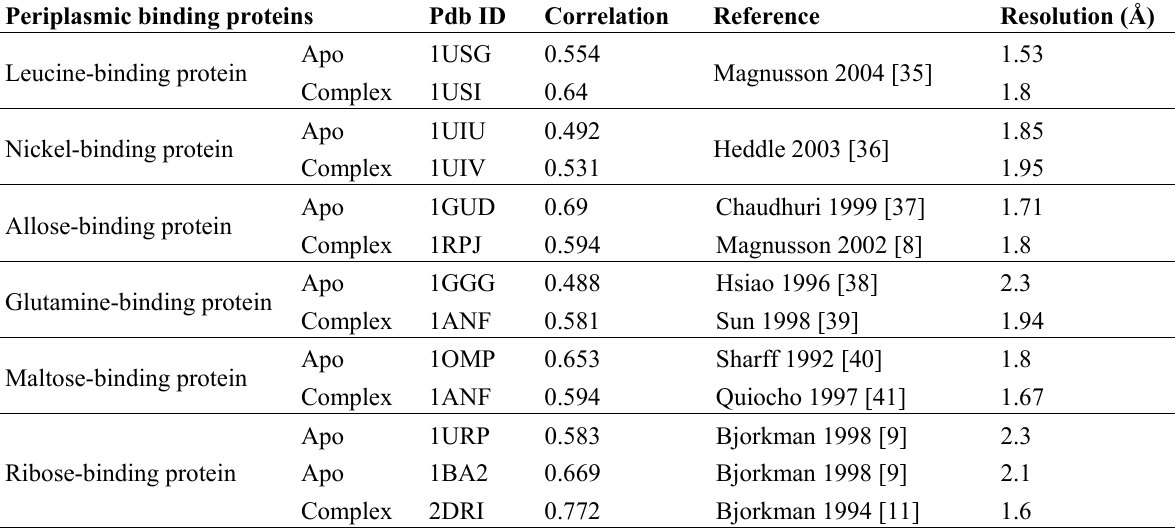
Table 1. The correlation coefficient of the B-factor between the experiment and Gaussian Network Model (GNM) of RBP and five other proteins belonging to the Escherichia coli